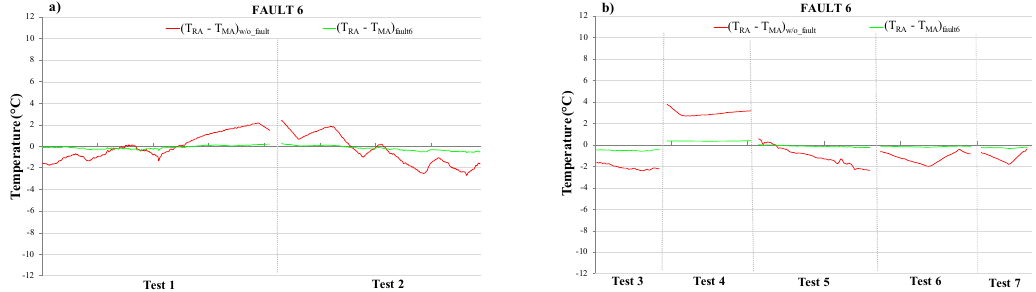
Figure 12. Comparison between normal operation and operation with fault 6: test 1, 2 ( a ), test 3, 4, 5, 6, 7 ( b ).